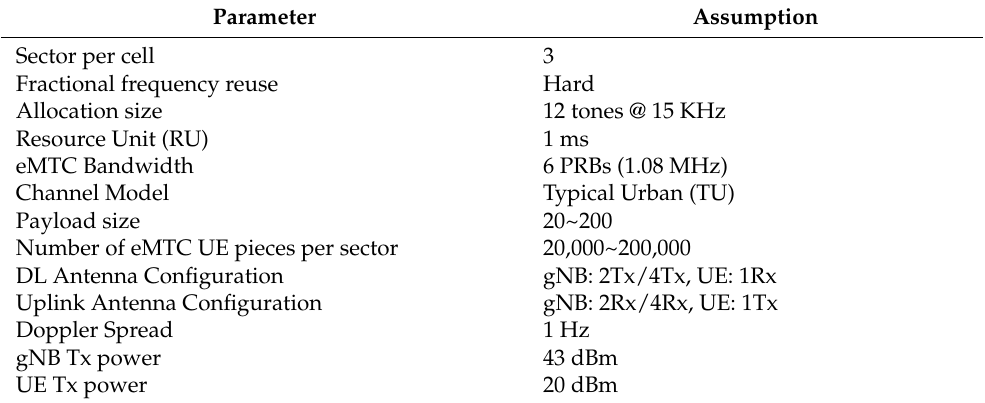
Table 1. Simulation Parameters. Parameter Assumption